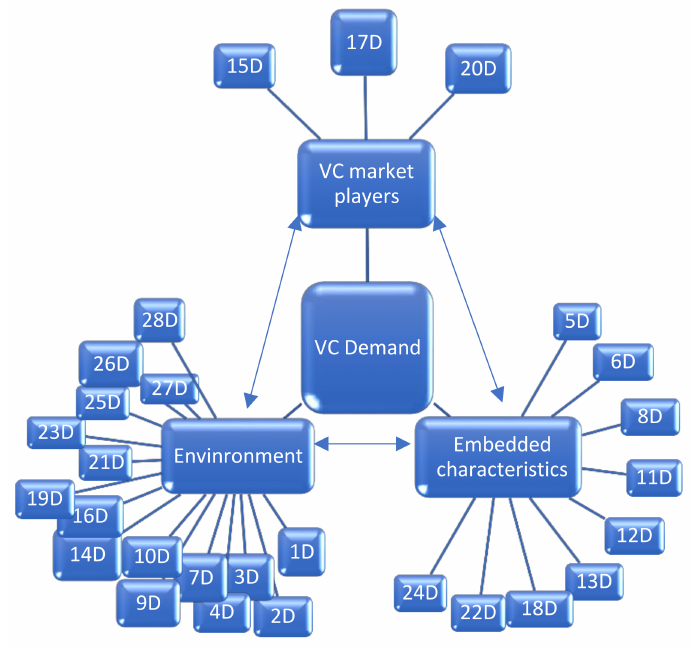
Figure 2. Factors influencing VC demand, their metacategories, and their interconnections.